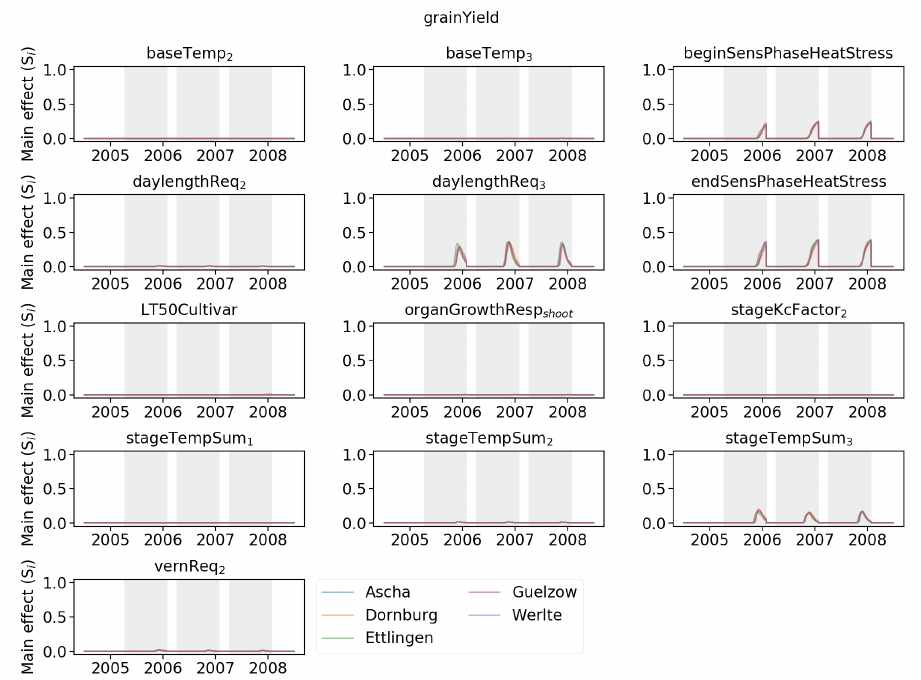
Figure A1. Daily S i values calculated using the extended FAST method for grainYield differentiated among the different